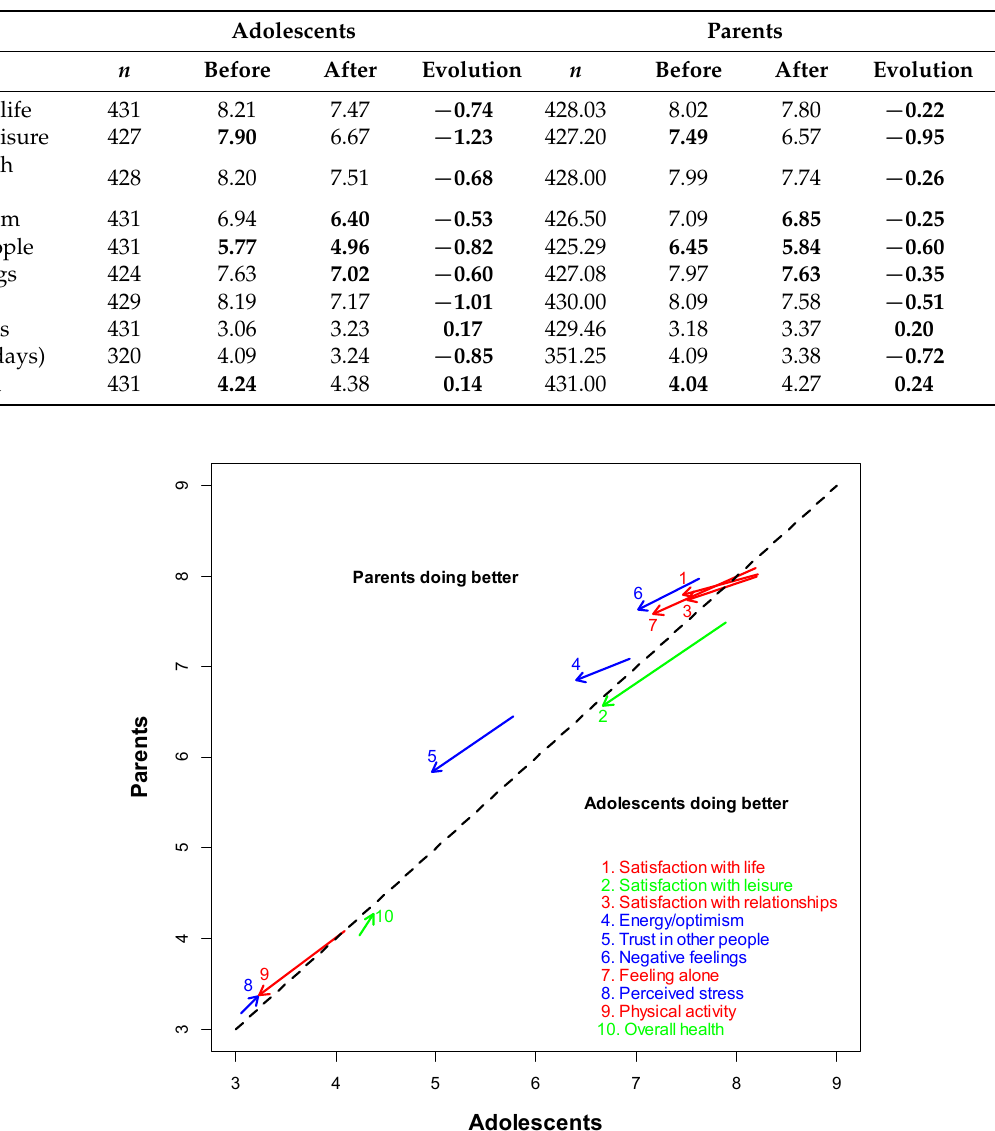
Table 2. Evolution of well-being during the partial lockdown. We provide the number of usable observations, the average value of each indicator before and after the partial lockdown, and the corresponding average evolution separately for adolescents and their parents. Evolutions significant at the 95% level according to a Benjamini–Hochberg adjusted t -test appear in bold. Similarly, when the “before” scores are significantly different between adolescents and parents they appear in bold, and the same is true for the “after” scores. The last column provides the p -value of a paired t -test between the evolution of the adolescents and their parents.